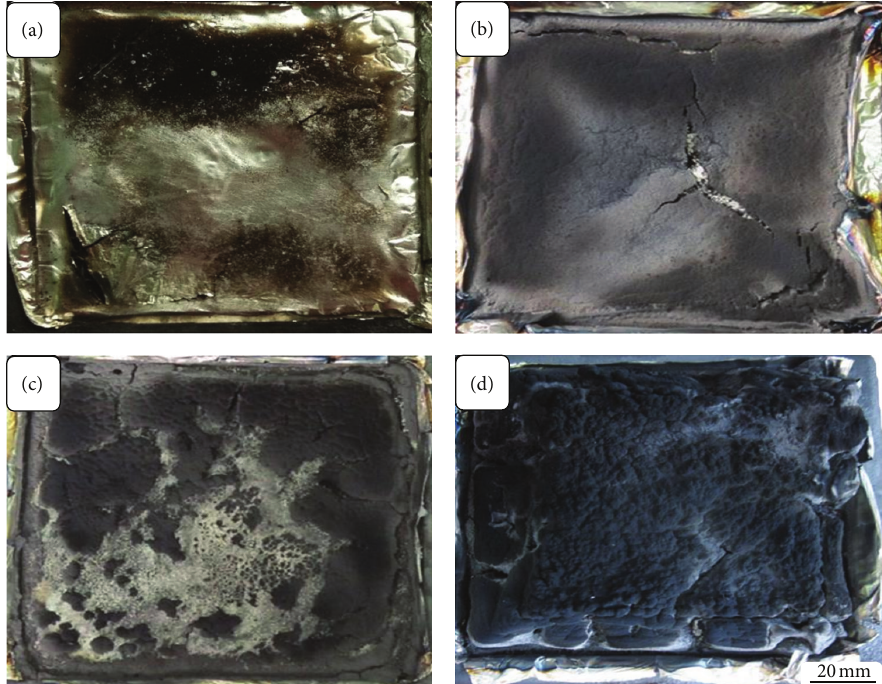
Figure 10: Digital photographs of PP and the flame retardant PP after the cone calorimetric test: (a) PP, (b) PP-1, (c) PP-2, and (d)